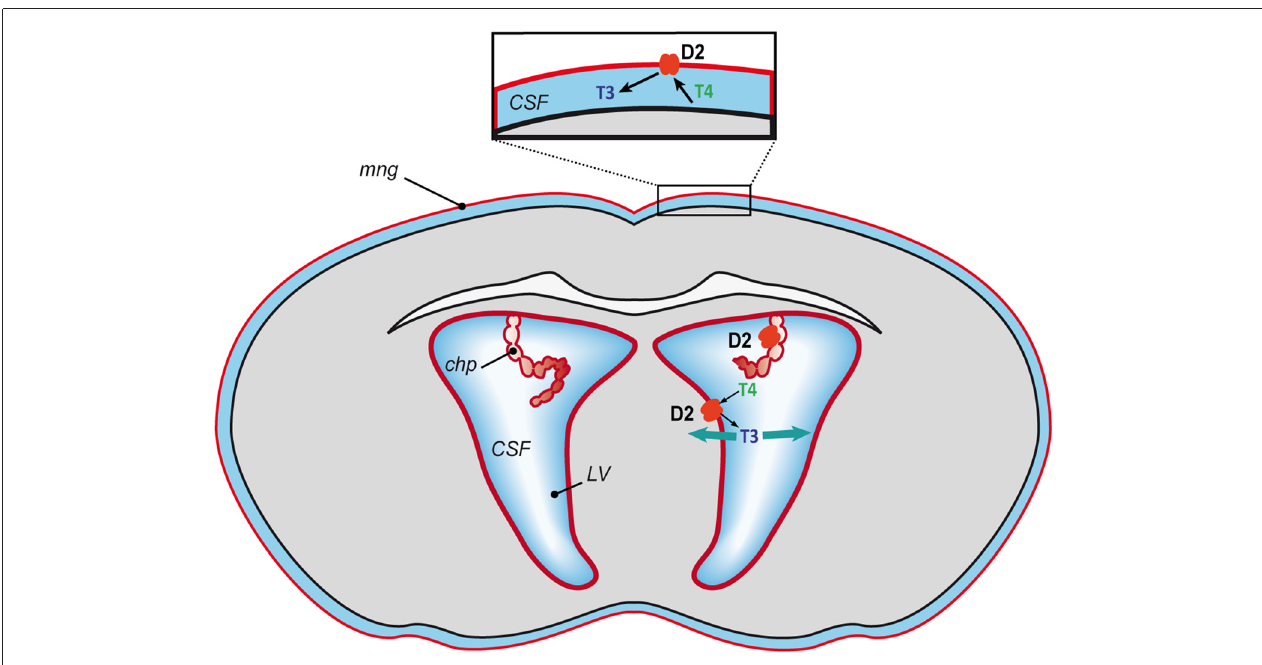
FIGURE 2 | Proposed model of T3 availability to the mouse developing brain. T4 mostly of maternal origin reaches the brain, gets transported into the cerebrospinal fluid and converted into T3 by D2 (in red) at the blood-cerebrospinal fluid barrier (meninges and choroid plexus) and at the lateral ventricles. From the cerebrospinal fluid the T3 could spread throughout the brain and access the neural cells to exert its action. CFS, cerebrospinal fluid; chp, choroid plexus; LV, lateral ventricles and mng,